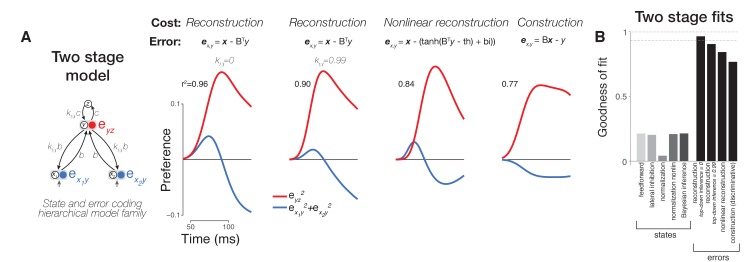
Comparison of variants of error coding hierarchical models that use different algorithms for online inference.(A) Additional varieties of error computing networks can be generated by varying the online inference algorithm that they use. In one case, inference does not utilize top-down information between stages (classic error backpropagation; between-stage feedback connections shown are not used in these networks during runtime). On the other hand, between-stage feedback can be used to optimize online estimates such as in more general forms of error backpropagation and predictive coding. We approximated these two extremes by including a parameter (ktd, see Materials and methods) controlling the relative weighting of bottom-up (feedforward) and top-down (feedback) evidence during online inference (first and second panels). We found that top-down inference between stages was not necessary to produce the appropriate error signal dynamics, and ktd was equal to zero (similar to the lack of inference in classic error backpropagation) in our best fitting two-layer (first column) and three-layer (Figure 5A, second column) models although models with ktd ~ 1 also performed well (second column). Models can also differ in their goal (cost function) which directly impacts the error signals computed (equations in top row). Under a nonlinear reconstruction goal (emulating the nonlinear nature of spiking output), the resulting error signals were still consistent with our data (third column). A simple sigmoidal nonlinearity, however, did lead to additional details present in our neural data such as a rapid return of stimulus preference to zero in the hidden layer. When we tested a discriminative, construction goal more consistent with a supervised learning setting where high-dimensional bottom-up responses simply have to match a low-dimensional downstream target signal as in classification tasks, we found that the errors of construction did not match the data as well as reconstruction errors (compare fourth column to first three columns). (B) Goodness of fit to population neural data for all two stage models including two layer versions of state (feature) coding controls (same format as Figure 5B).